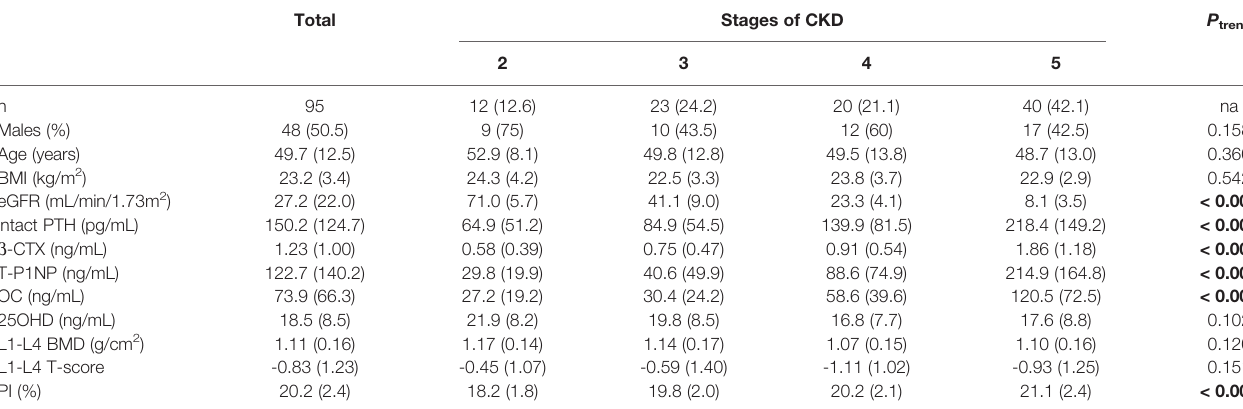
TABLE 1 | Baseline characteristics by the stages of